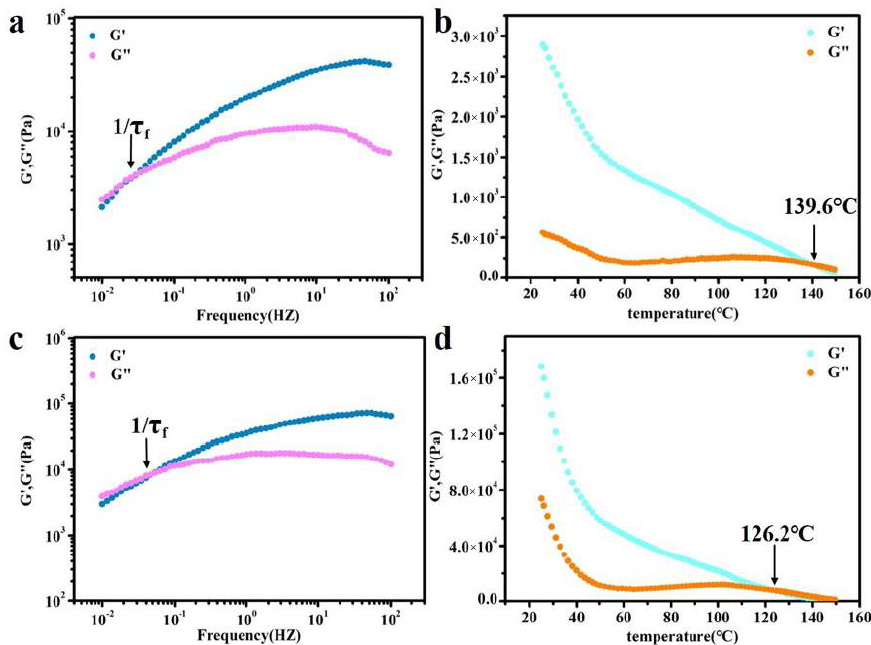
Figure 5. ( a ) Rheological curves of BDM-1.7 elastomers (90 ◦ C) for deducing relaxation time of chain flow transition τ f ; ( b ) Temperature sweep of rheological testing for the BDM-1.7 elastomer; ( c ) Rheological curves of BDH-1.7, elastomers (90 ◦ C) for deducing relaxation time of chain flow transition τ f ; ( d ) Temperature sweep of rheological testing for the BDH-1.7